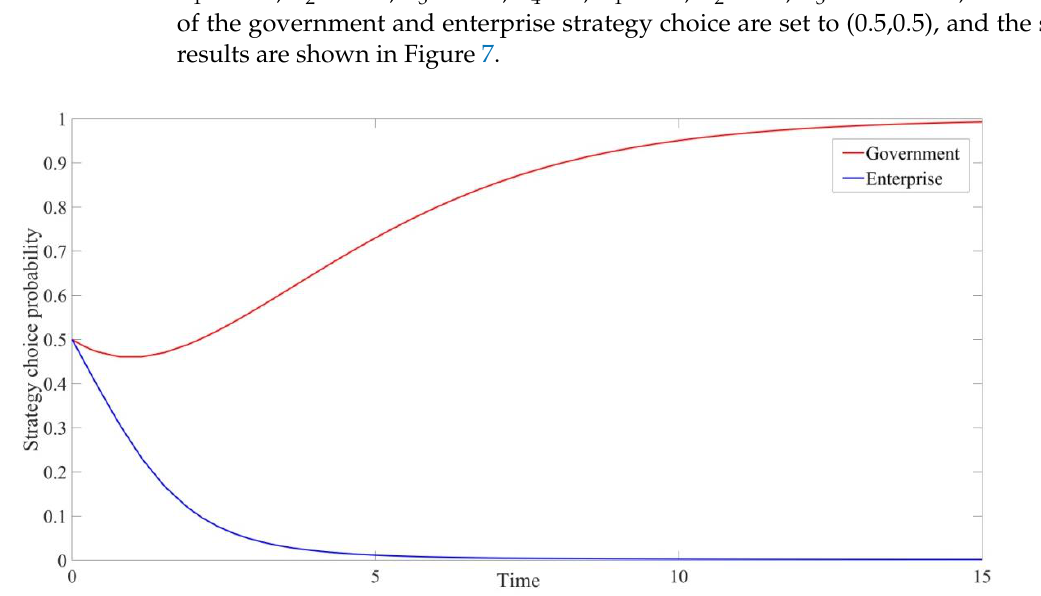
Figure 8. Simulation results of the partial equilibrium point (1,0). It can be seen from the simulation results that the system converges to point (0,1) in this case, which is consistent with the analysis of the above evolutionary stability strate-